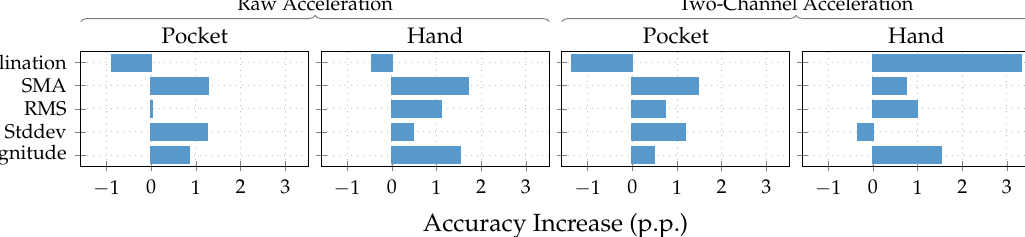
Figure 15. Achieved increases of accuracy (p.p.) by independently adding each virtual sensor on top of only the hardware sensors, for pocket-case and hand-case, using the PCA with 5 remaining dimensions and a window length of 2s, using raw acceleration ( left ) and two-channel acceleration ( right